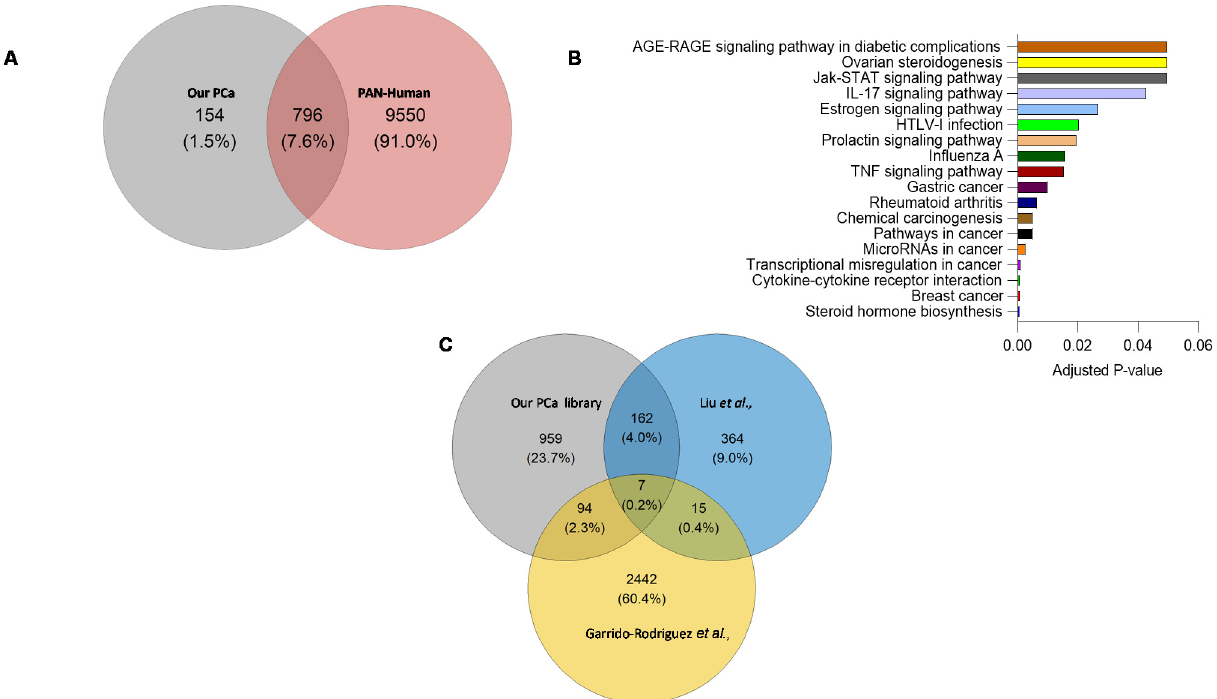
Figure 4. ( A ) Overlap between proteotypic proteins in the combined-PCa and Pan-Human spectral libraries. ( B ) KEGG pathway analysis of proteins unique to combined-PCa spectral library. ( C ) Overlap of the total protein count of our combined serum PCa spectral library and PCa spectral libraries previously published from PCa tissue and cell lines samples [19,20].